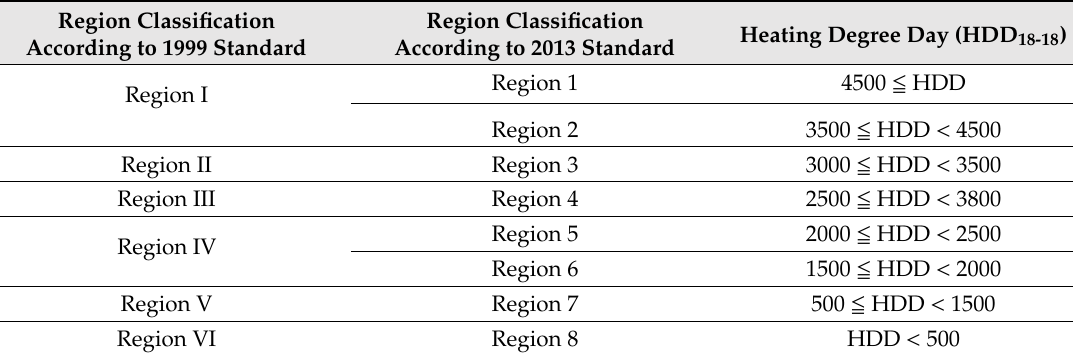
Table 8. Japanese heating degree day (HDD 18-18 ) classification.